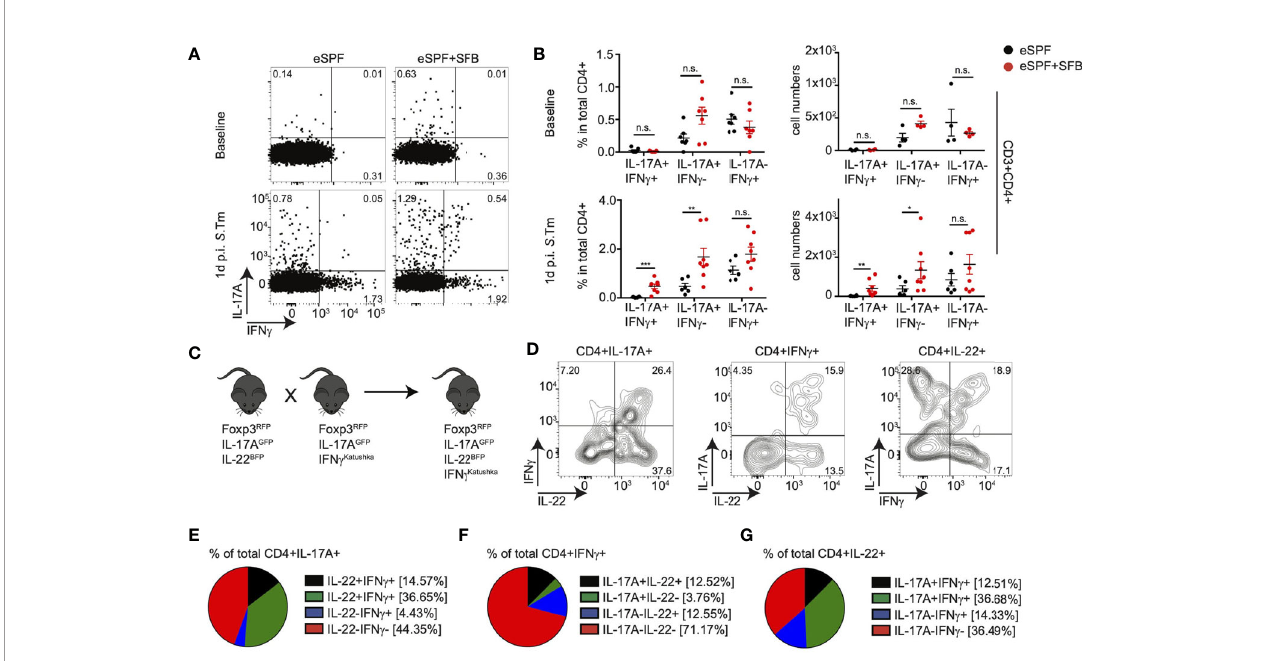
FIGURE 5 | IL-22 producing CD4 T cells are induced by SFB independent of IFN g + CD4 T cells. (A, B) LPL were isolated from baseline and 1d post S. tm . infection from the cecum of IL-17A GFP IFN- g Katushka FoxP3 RFP mice harboring eSPF or eSPF+SFB. Representative FACS plots (A) and percentages and absolute numbers (B) of CD3+CD4+ cells expressing IL-17A and IFN- g in the absence of ex vivo restimulation. (C) A quadruple knock-in reporter mice were derived by crossing IL-17A GFP IL-22 BFP FoxP3 RFP and IL-17A GFP IFN- g Katushka FoxP3 RFP mouse lines. (D – G) LPL were isolated from 1d post S . tm. infection from the cecum of quadruple reporter mice and analyzed by FACS. Representative FACS plots of CD3+CD4+ cells expressing IL-17A, IL-22, and/or IFN- g in the absence of ex vivo restimulation (D) . Frequencies of cytokine secretion by CD4 T cells expressing IL-17A (E) , IFN- g (F) , or IL-22 (G) . Data represent n = 6 – 9 mice/group as mean ± SEM from at least two independent experiments. P-values indicated represent an unpaired Student ’ s t test *p < 0,05; **p < 0,01; ***p < 0,001; n.s., not signi fi cant. See also Supplementary Figure S5